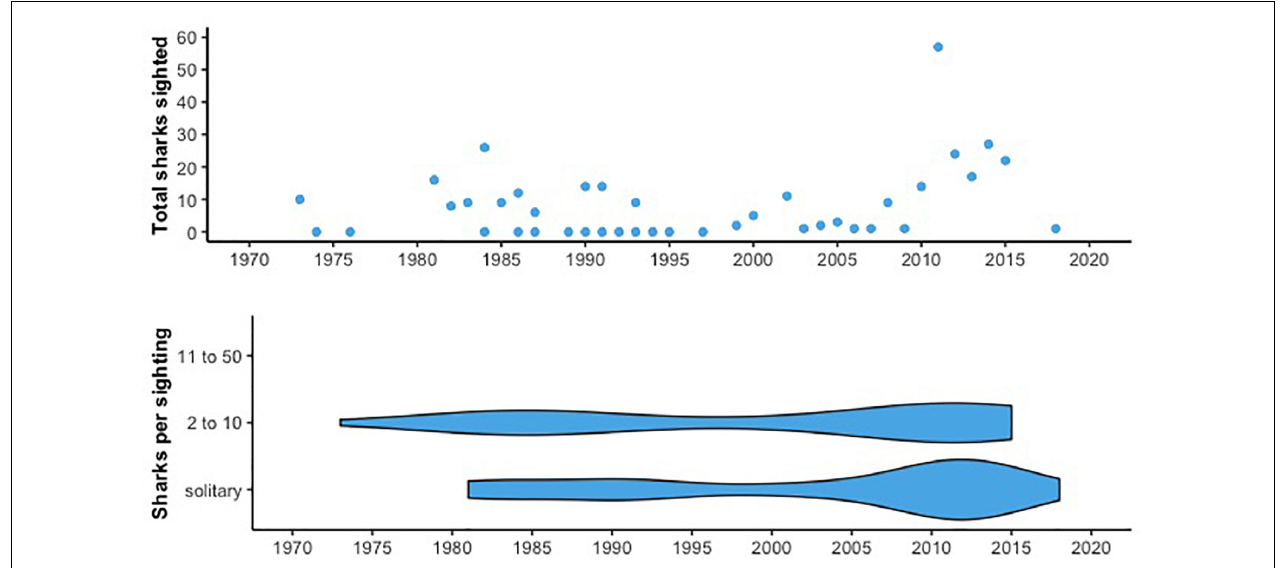
FIGURE 3 | (Top) The total number of sharks sighted opportunistically each year in the non-systematic survey data. Slight peaks in sightings occur between 1980 and 1990, and between 2011 and 2018. (Bottom) Number of sharks per sighting, binned as in Figure 2 . All records report at most. All records report at most 10